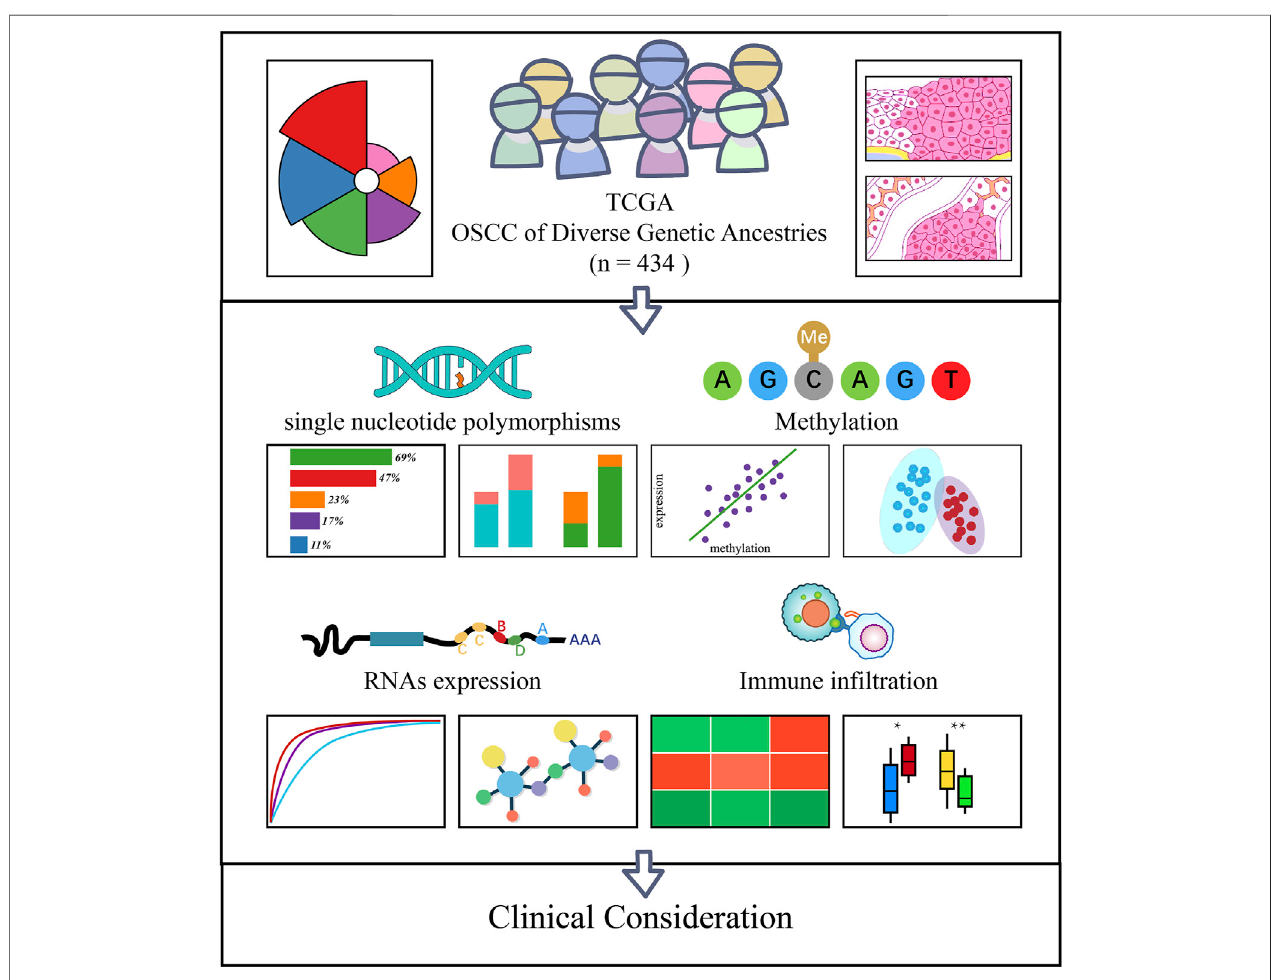
FIGURE 1 | Flowchart showing an overview of our study design.